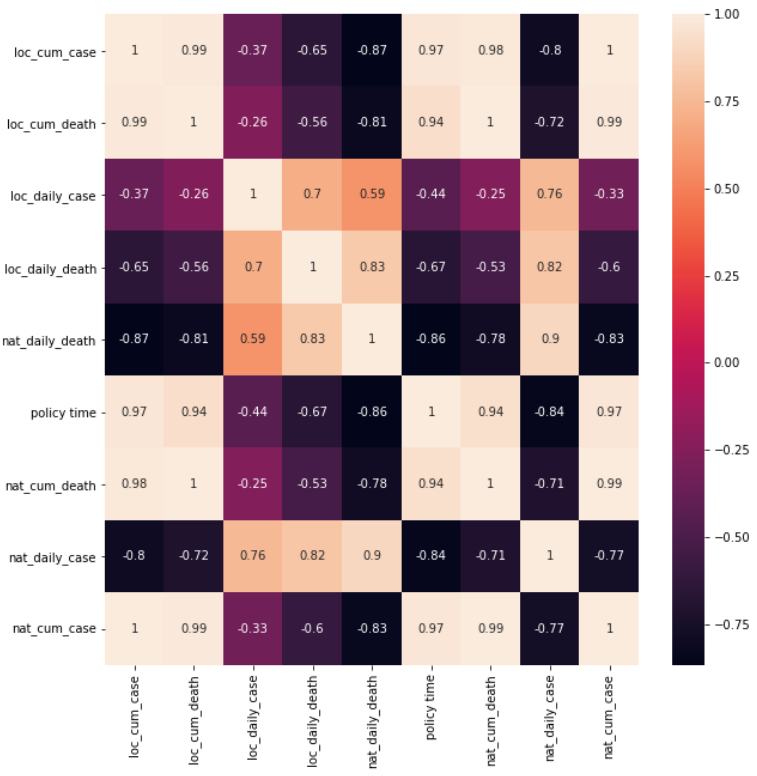
Figure A1. The correlation heatmap of independent variables.